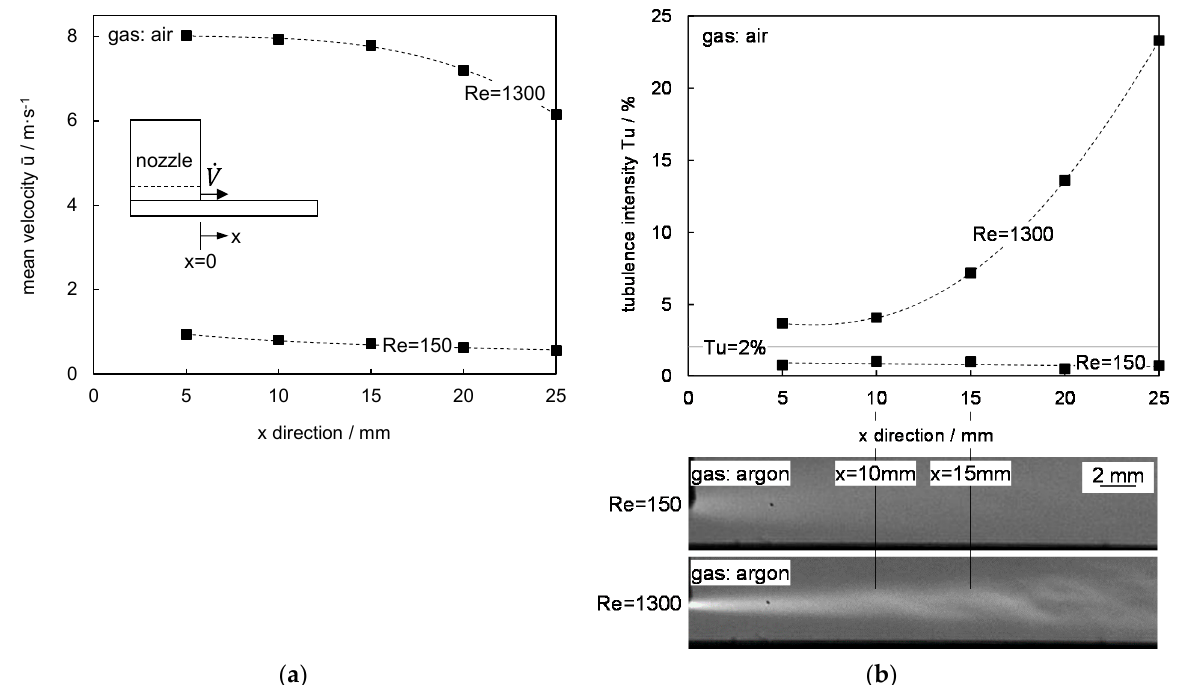
Figure 5. ( a ) Mean velocity of flow depending on distance to orifice ( x = 0); ( b ) turbulence intensity depending on distance to orifice and related Schlieren images for Argon.